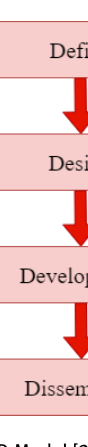
Figure 1: Flowchart Four-D Model